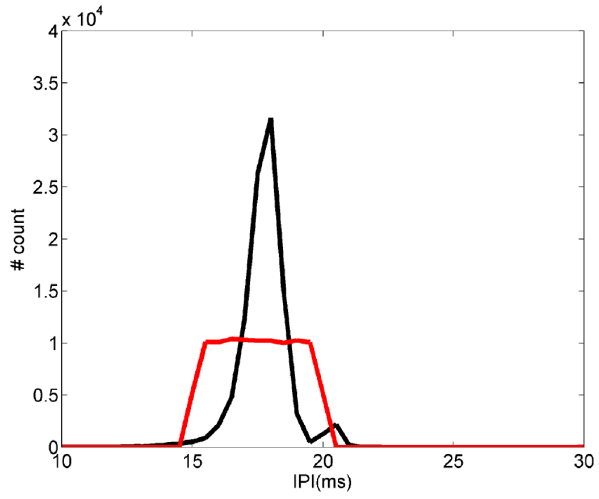
Figure 2. Stimuli histograms. Real IPI stimulus histogram (in black). The IPIs were recorded (30 min) from a non-stimulated fish immediately after being introduced in the tank. Random IPI stimulus histogram (in red). IPIs from 15 ms to 20 ms were generated with the same probability (flat distribution) by computer.